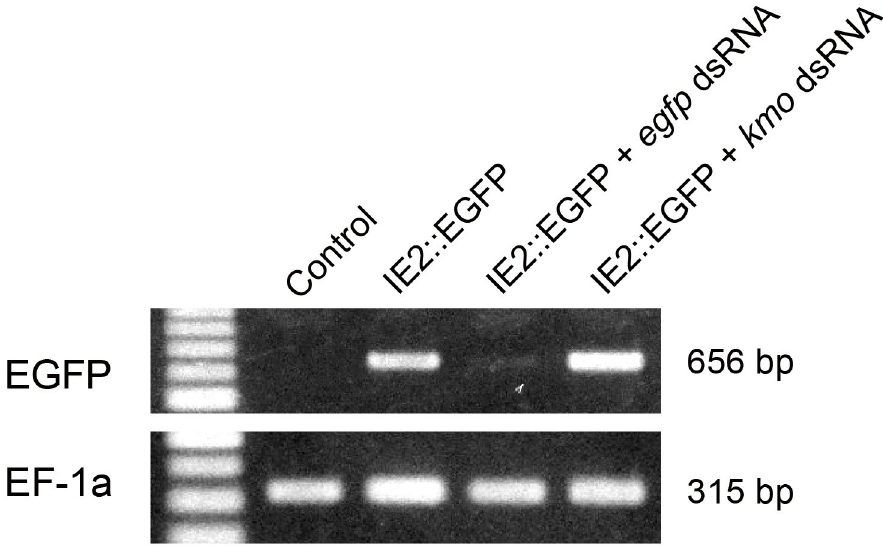
Fig 8. Comparison of transcripts levels by RT-PCR. Short fragments of the egfp gene (656 bp, top panel) and A . mellifera elongation factor-1 α gene (315 bp, bottom panel) were amplified using gene-specific primer sets and total RNA extracted from Day 5 cells as the templates. egfp gene transcripts were detected in cells transfected with the IE2:: EGFP vector, but not in cells to which dsRNA corresponding to the egfp gene was applied. Each lane indicates the treatments that ex vivo cells received: no treatment (Control), transfection of the IE2::EGFP vector (IE2::EGFP), transfection of the IE2::EGFP vector associated with egfp dsRNA (IE2::EGFP + egfp dsRNA), and transfection of the IE2::EGFP vector associating with dsRNA corresponding to an unrelated A . mellifera kynurenine 3-monooxygenase ( kmo ) gene (IE2::EGFP + kmo dsRNA).